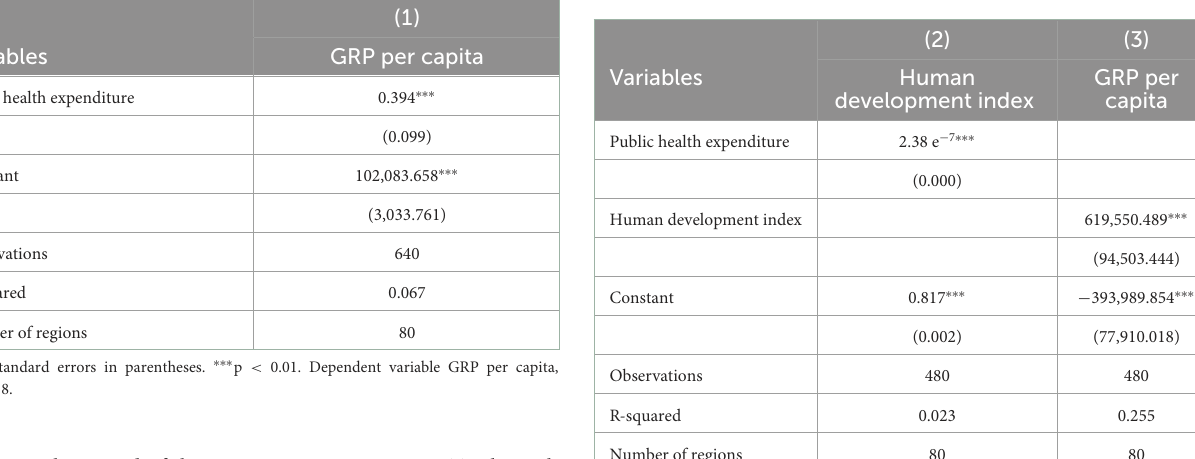
TABLE 1 Multiplier calculation (M1) in the fixed effects regression. TABLE 2 Calculation of M2 in the fixed effects regression, models 2 and 3,